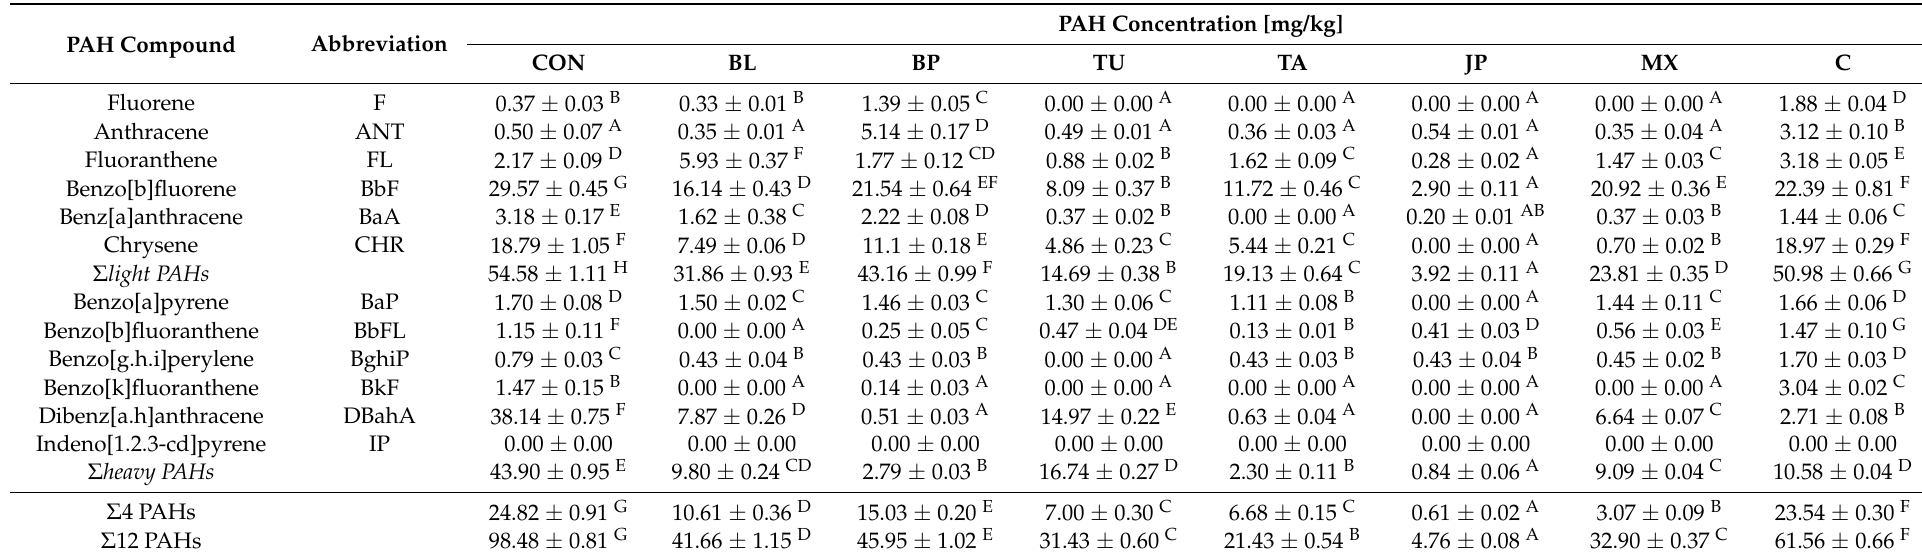
Table 7. The effect of marinade on PAH formation (mean ± standard deviation) in grilled